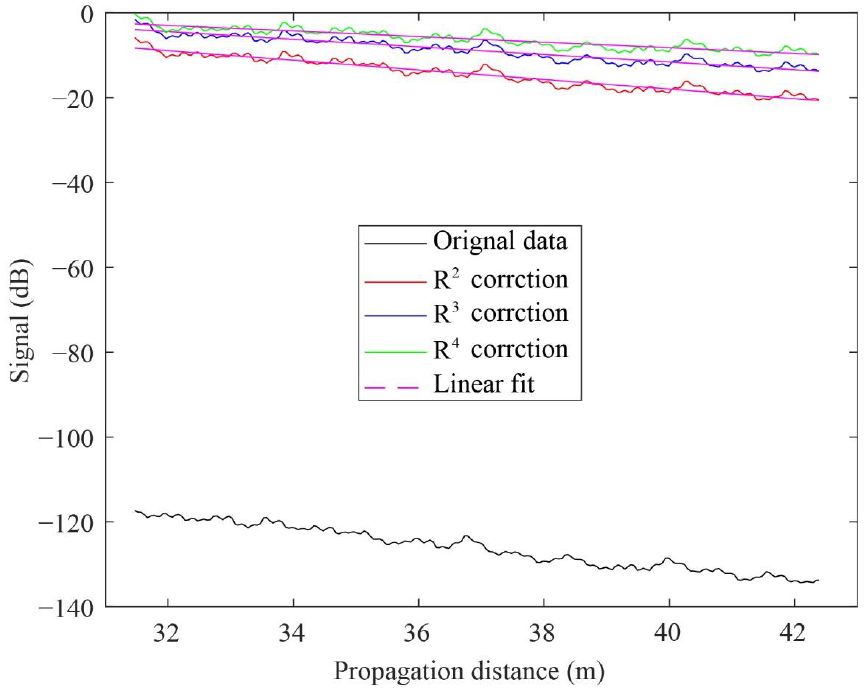
Figure 8. The attenuation estimated result adjacent 1700 tracks of LPR data . ε=3.5 is used for time -to-propagation distance conversion.